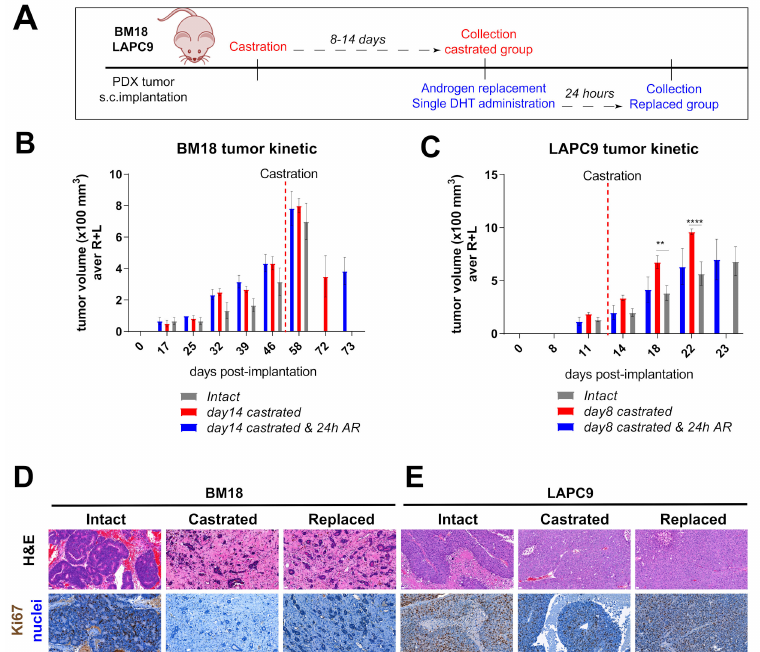
Figure 1. In vivo tumor growth properties of androgen-dependent BM18 versus androgen-independent patient-derived xenograft (PDX) models. ( A ) Scheme of in vivo BM18 and LAPC9 experiments, including the timeline of castration, androgen replacement (single dihydrotestosterone (DHT) administration) and collection of material for transcriptomic analysis. ( B ) BM18 PDX tumor growth progression in time. Groups: (1) intact tumors (collected at max size, n = 3), (2) castrated (day 14, n = 4) and (3) castrated, followed by testosterone readministration (castrated-testosterone) (day 15 since castration and 24 h since the androgen receptor (AR), n = 3). R; right tumor, L; left tumor per animal. ( C ) LAPC9 PDX tumor growth progression in time. Groups: (1) intact tumors (collected at max size, n = 3), (2) castrated (day 8, n = 4) and (3) castrated, followed by testosterone readministration (castrated-testosterone) (day 9 since castration and 24 h since AR, n = 3). Tumor scoring was performed weekly by routine palpation; values represent average calculations of the tumors of all animals per group (considering 2 tumors, left, L, and right, R, of each animal). Error bars represent SEM, calculated considering the no. of animals for each time point. Ordinary two-way ANOVA with Tukey’s multiple comparison correction was performed, p < 0.01 (**) and p < 0.0001 (****). ( D ) Histological morphology of BM18 and ( E ) LAPC9 (from intact, castrated and androgen-replaced hosts), as assessed by Hematoxylin and Eosin staining (H&E, top). Scale bars: 20 µ m, and proliferation marker Ki67 protein expression (bottom